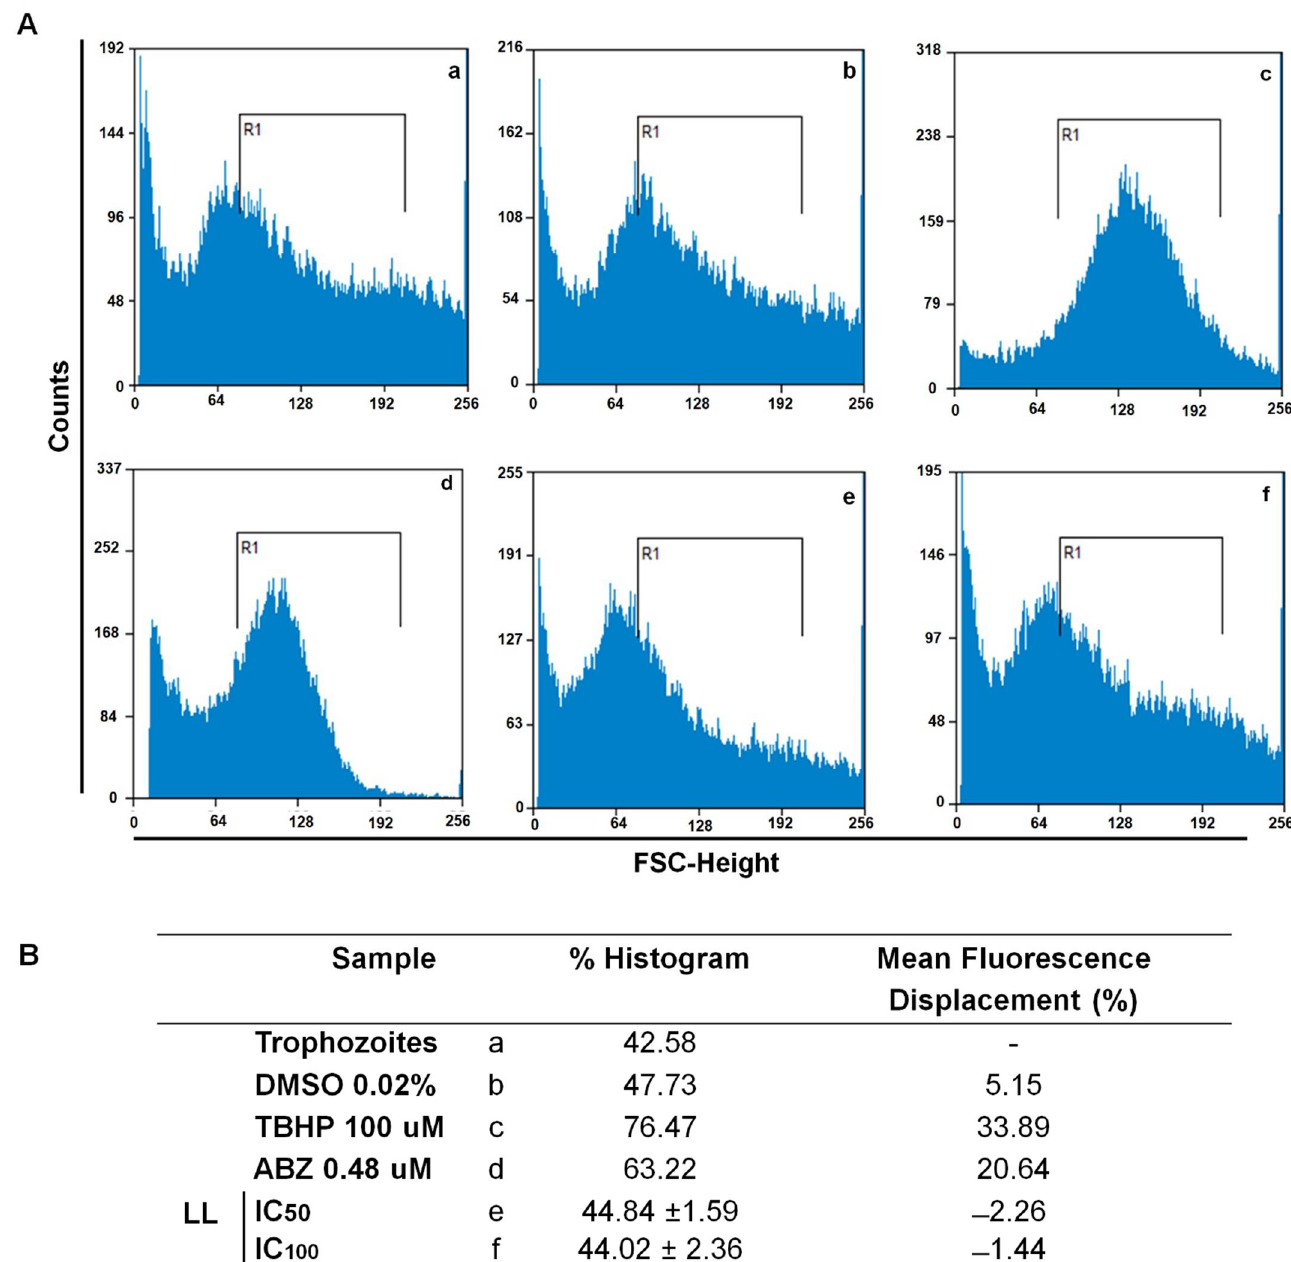
Figure 3. Linearolactone (LL) does not cause oxidative stress in G. intestinalis trophozoites. ( A ) Strain WB trophozoites were cultured in TY1-S-33 medium ( a ), exposed to vehicle [0.02% dimethyl sulfoxide (DMSO) ( b ), or exposed to TBHP (100 µM) ( c ) and albendazole 0.48 µM (ABZ) ( d ), LL at IC 50 ( e ) and IC 100 ( f ), incubated with dichloro-dihydro fluorescein diacetate to detect ROS. Fluorescence was analyzed by FCM [X-axis: fluorescence scatter (FSC); Y-axis: protozoa count]. R1 showed the ROS fluorescence for untreated and DMSO-treated protozoa. ( B ) The percentages of trophozoites with different fluorescence are shown. The results are expressed as the mean ± standard deviation ( n = 3).